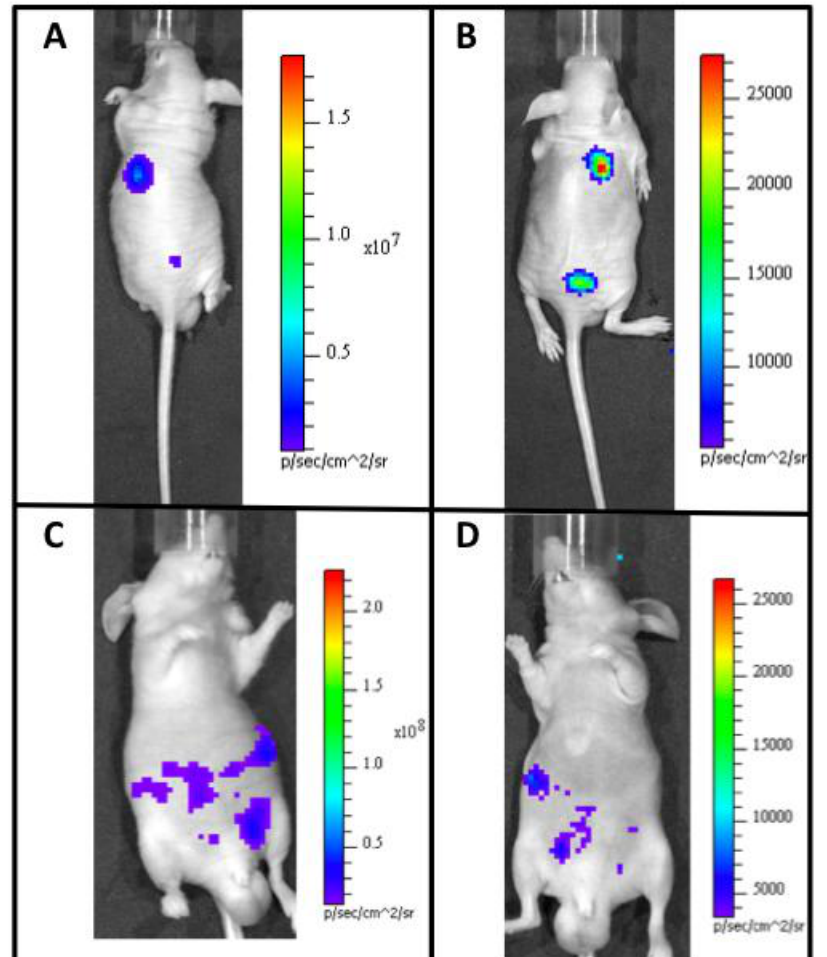
Figure 1. In vivo comparison of the FLuc and Lux reporter systems in a mouse